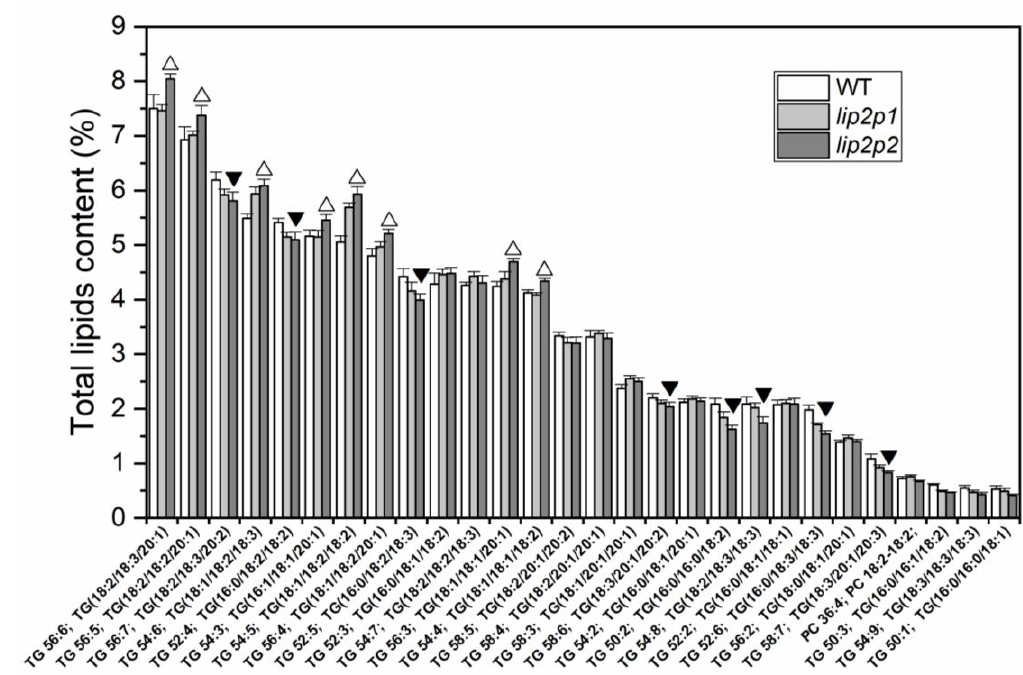
Figure 5. Representative TAG and glycerolipid species of the differences found between Arabidopsis control (WT, white columns) and octanoyltransferase mutants ( lip2p1 , grey, and lip2p2 , dark grey) mature seeds. Data are average values ± SD of three biological replicates. At the 0.05 level, data are significantly different for lip2p2 values.